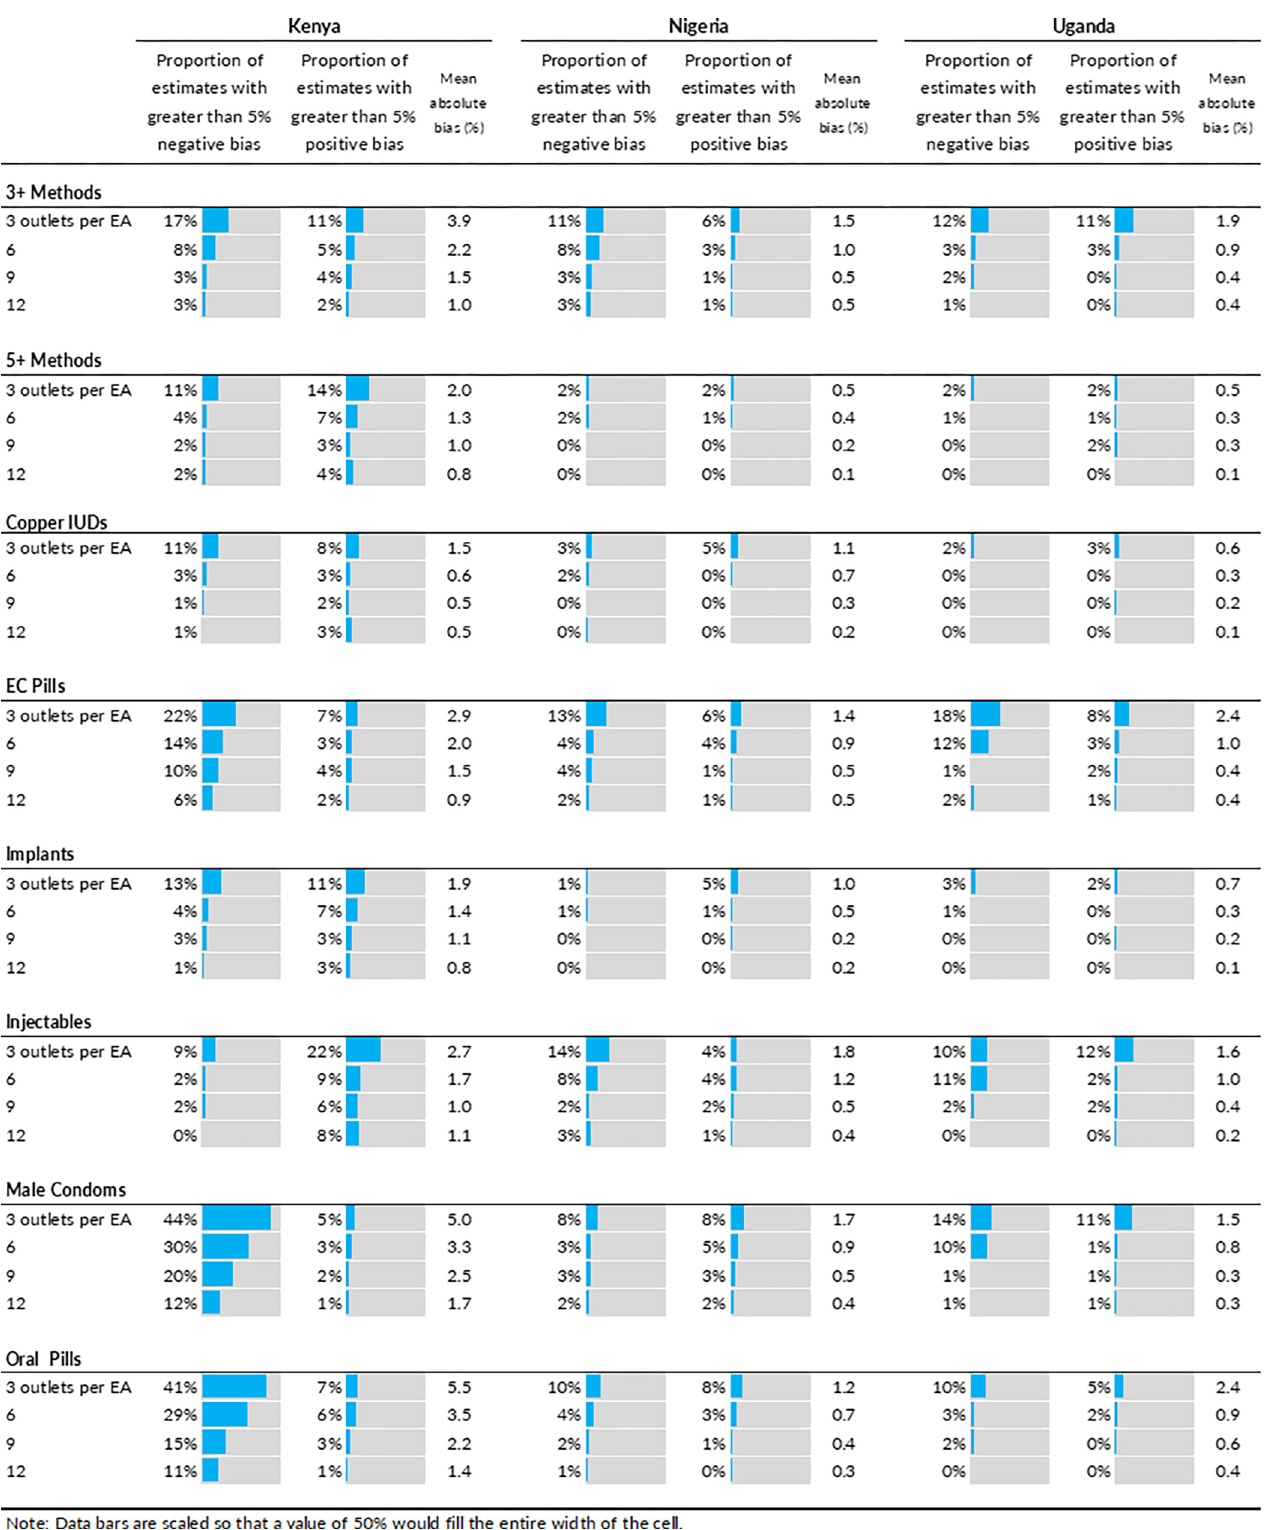
PLOS ONE | https://doi.org/10.1371/journal.pone.0271896 August 30,